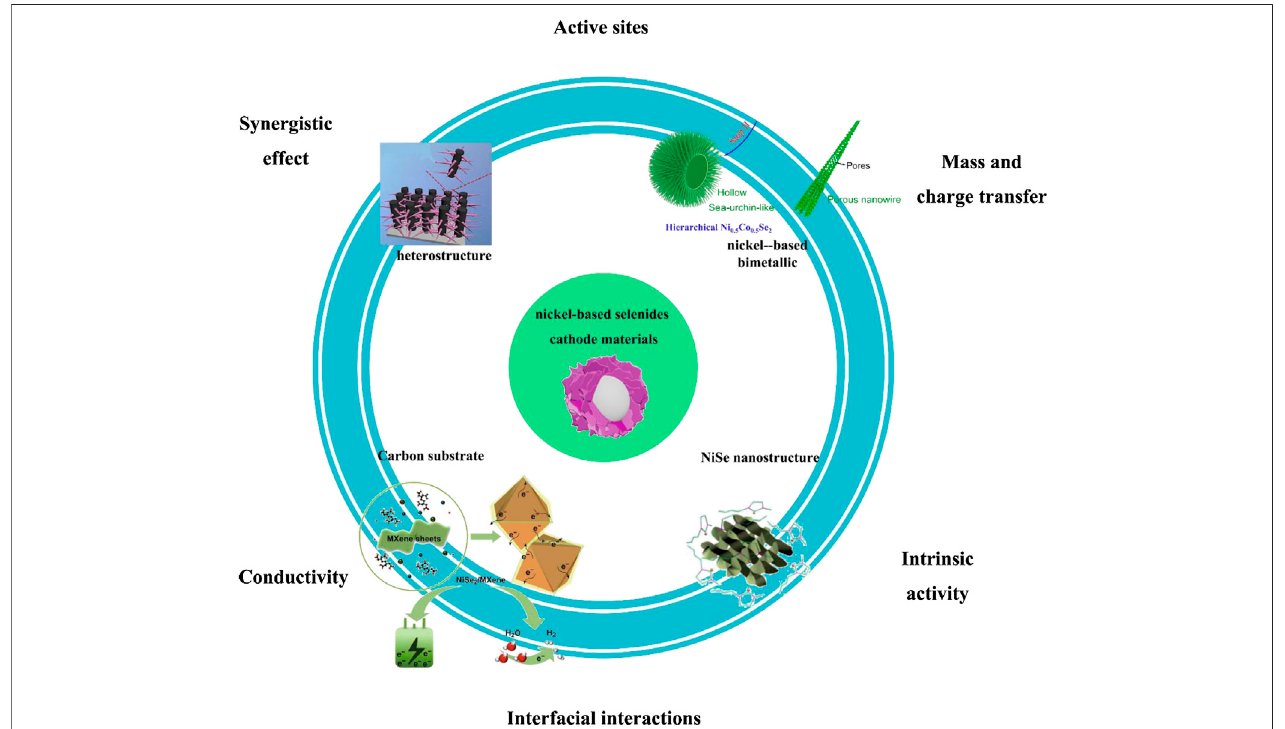
FIGURE 3 | nickel-based selenides as cathode materials for